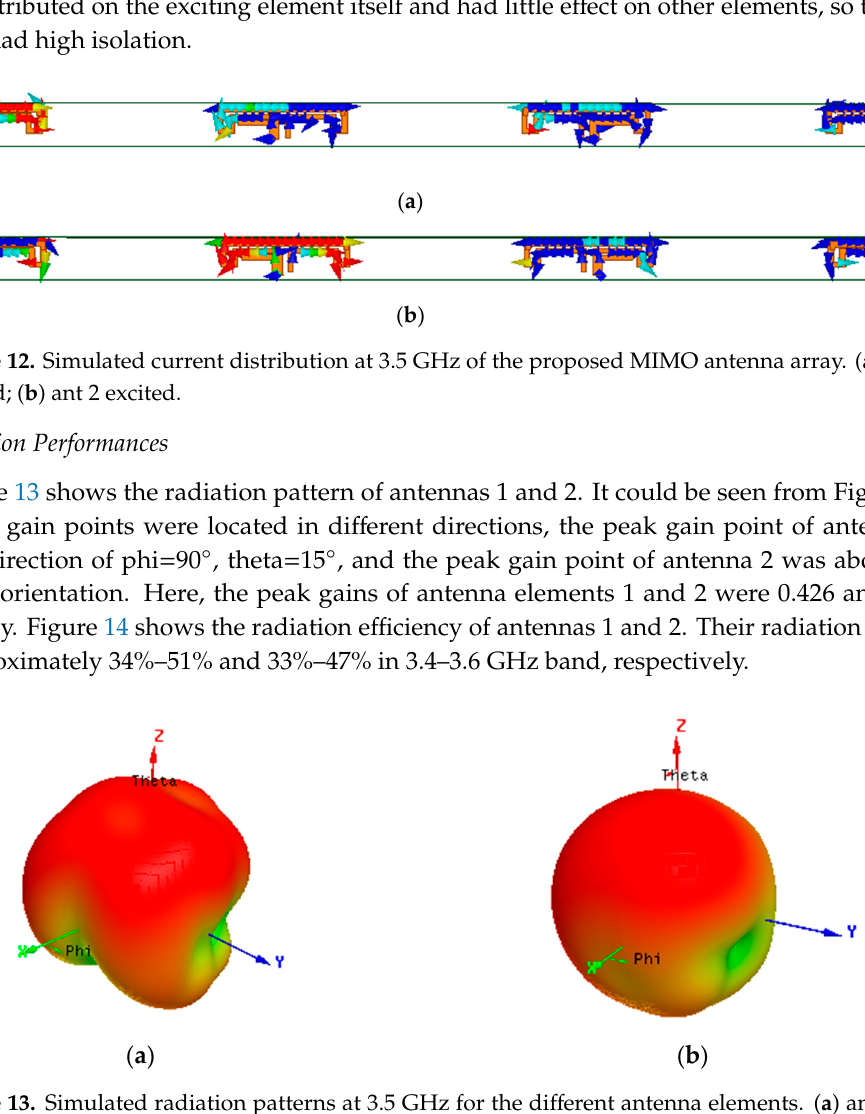
Figure 13. Simulated radiation patterns at 3.5 GHz for the different antenna elements. ( a ) ant 1; ( b ) ant 2.